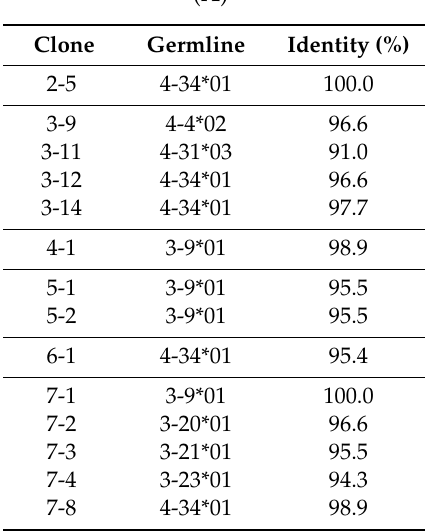
Table 3. ( A ) Identity of amino acid sequences of predicted proteins of the V H -encoding regions when comparing between germline genes and Ab-encoding genes of HI-positive clones; ( B ) Identity of amino acid sequences of predicted proteins of the V H -encoding regions when comparing between germline genes and Ab-encoding genes of HI-negative clones.